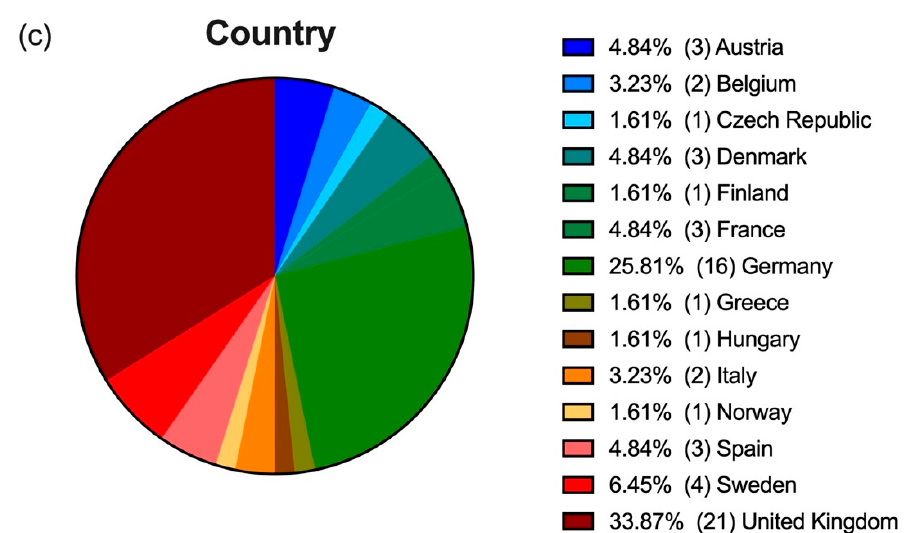
Figure 2. ( a ) Animal species for which the refinement protocols were described; ( b ) country; and ( c ) institution in which the research groups were working. Data are presented in percentages (total number).